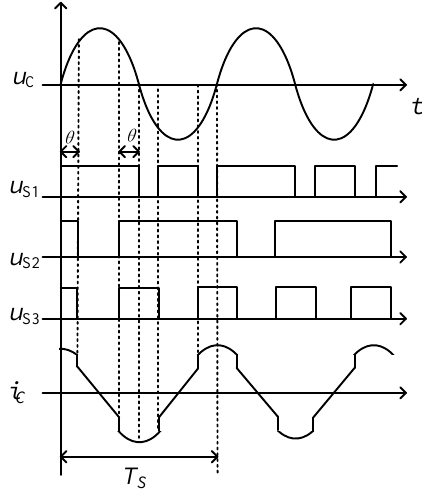
Figure 7. Waveforms of the adjustable capacitor.